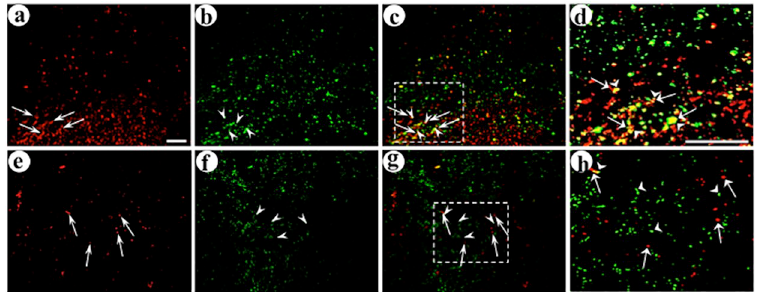
Fig 6. The synthetic peptide neurotransmitter in the presynaptic vector supports efficient gene transfer to connected neurons. The experimental design was as detailed in Fig 3 legend. Alternating sections containing POR cortex were analyzed for expression from the presynaptic vector and either the targeted or control postsynaptic vector, using immunofluorescent costaining. The upper layers of POR cortex were examined. (A-D) Delivery of this presynaptic vector, followed by the targeted postsynaptic vector, supports efficient gene transfer to connected neurons; (A) His tag-IR (Texas red-conjugated secondary antibody), (B) GFP-IR (FITC-conjugated secondary antibody), (C) merge, and (D) merge, an enlarged area showing specific transduced axons either proximal to, or distant from, a transduced dendrite. Arrows, transduced axons; arrowheads, transduced dendrites. (E-H) Delivery of this presynaptic vector followed by the untargeted, control postsynaptic vector supported only a low level of gene transfer to connected neurons; (E) His tag-IR, (F) flag-IR (FITC-conjugated secondary antibody), (G) merge, and (H) merge, an enlarged area with His tag-IR axons and flag-IR dendrites that are distant from each other. Scale bars: (A-C and E-G) 50 μ m, and (D and H) 50 μ m.